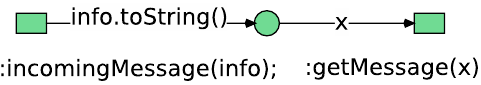
Figure 12. Communication client net.